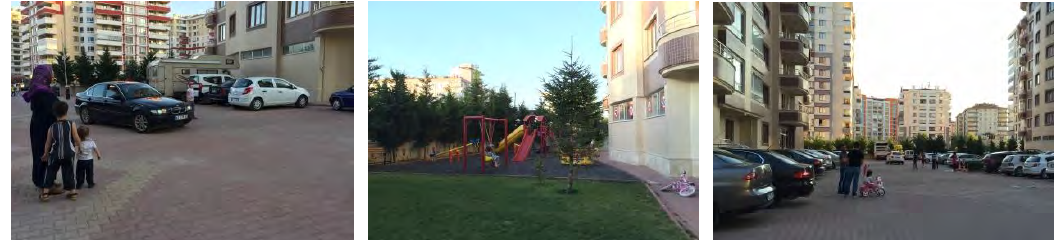
Figure 5: The lack of distinction pedestrians/cars (left), playground (middle), playing children in the site